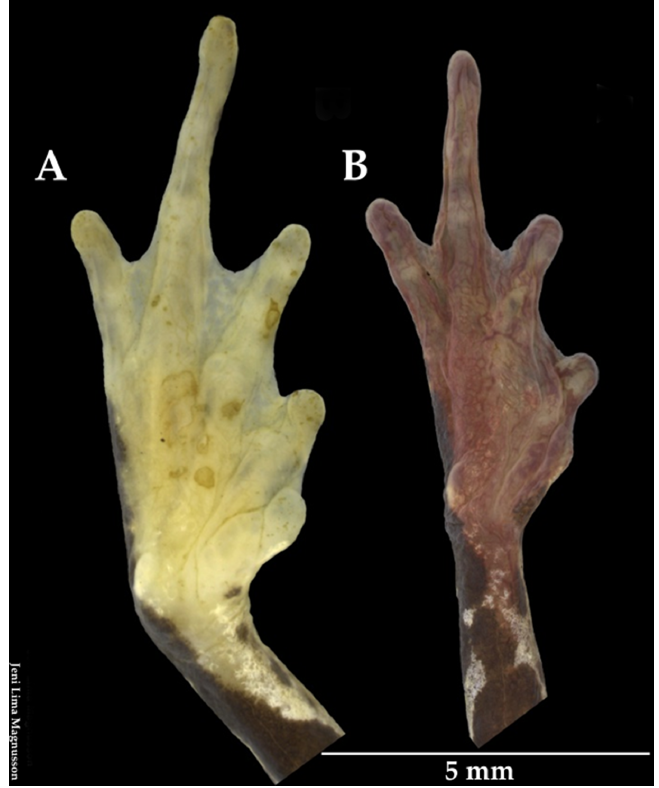
Figure 5. Ventral view of the foot of Atelopus manauensis sp. nov. in preservative: ( A ) allotype; ( B ) holotype.